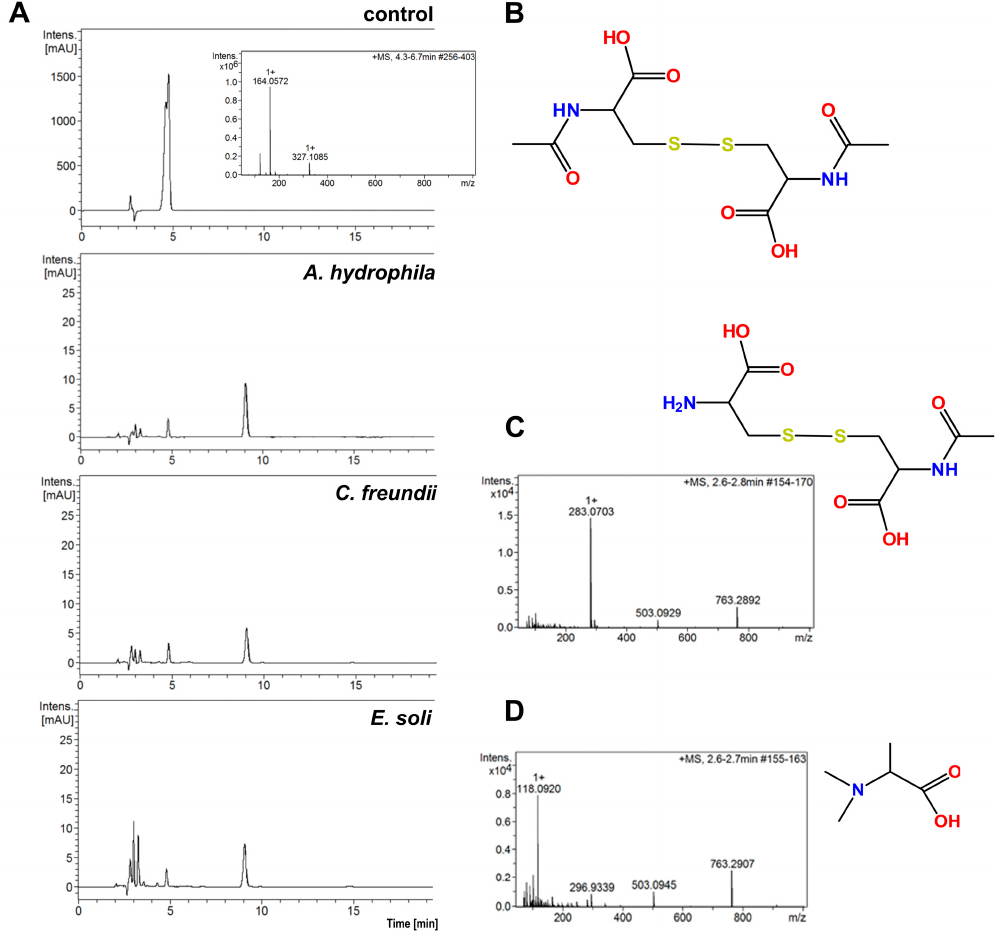
Figure 3. ( A ) HPLC chromatograms of solutions obtained after 4 h of incubation with 0.25% ( w / v ) NAC for three bacterial strains. The control was 0.5% NAC solution without bacterial incubation; ( B ) structure of the main NAC metabolite; ( C ) MS spectrum and structure of the polar metabolite of NAC from supernatant after 4 h incubation of A. tumefaciens with NAC, ( D ) MS spectrum and structure of polar metabolite of NAC from supernatant after 4 h incubation of E. soli with